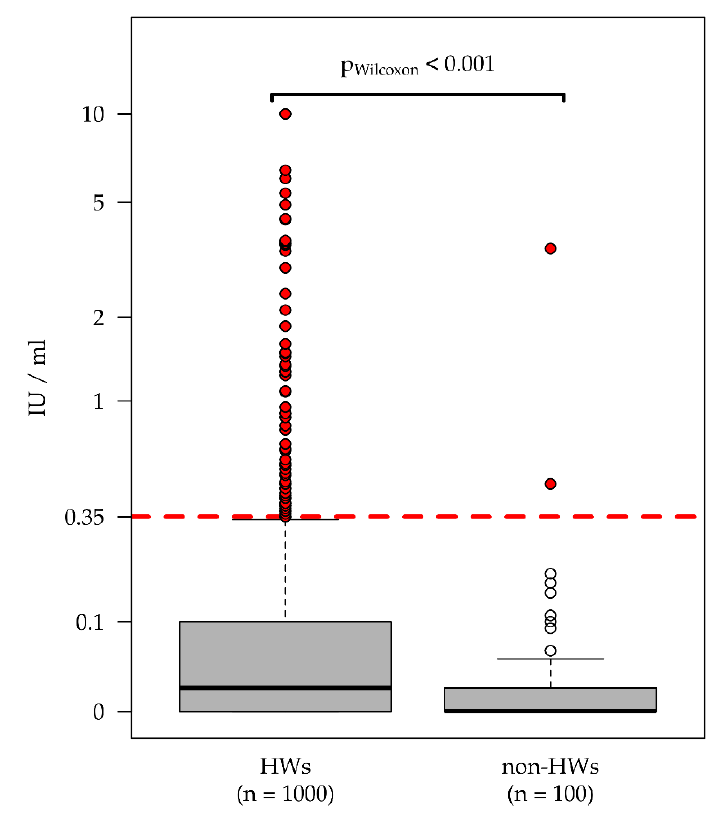
Figure 2. Amount of INF- γ value (tube TB1) by group (HWs vs. non-HWs). The multivariate analysis, taking into account age groups, gender, TB history, country of birth (Germany vs. not Germany) and employment in the health care sector, gives the following results: we identify an age e ff ect where the risk increases as the age group increases, which is statistically significant ( p = 0.009). There is no evident gender e ff ect ( p = 0.89). A near doubling of the risk for subjects with a TB history was demonstrated, and there was an e ff ect from both country of birth (OR = 9.2; 95% CI: 0.67 to 127.1; p = 0.090) and from employment in the health care sector (OR = 4.9; 95% CI: (1.32 to 43.7); p = 0.013). However, the latter two e ff ects combined with each other do not have a multiplicative e ff ect, but result in an OR of 8.7 (95% CI: 2.0 to 81.5; p = 0.002) (Figure 3) when interacting with one another.